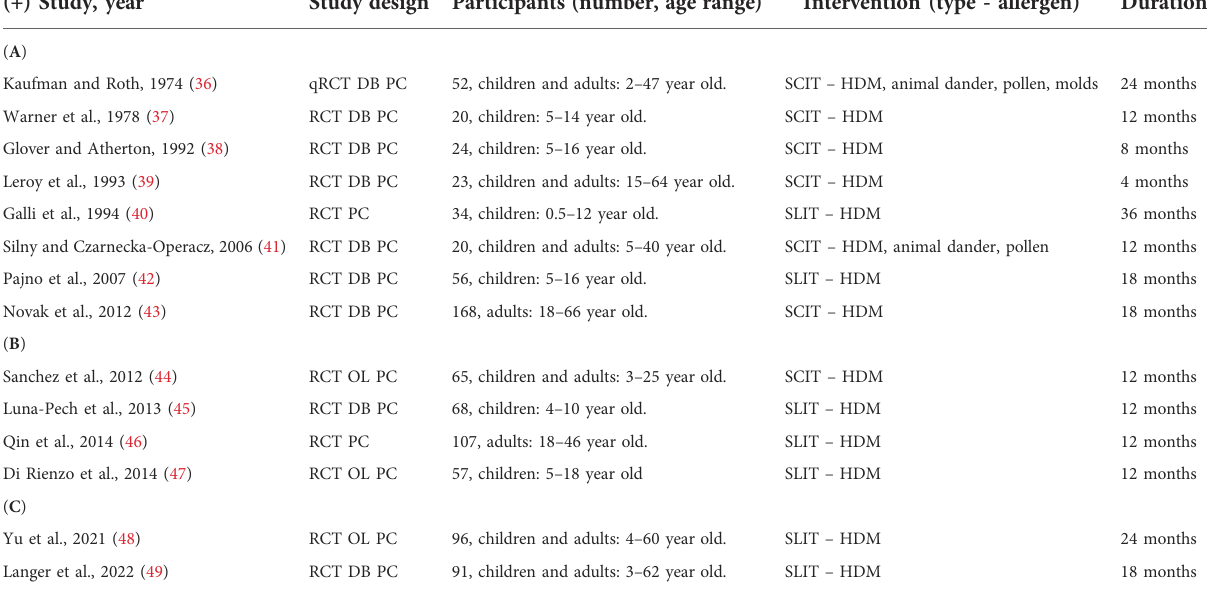
TABLE 1 Summary of the studies included in systematic review and meta-analysis, ( A ) adapted from Bae et al. (34) and ( B ) adapted from Tam et al. (35), and ( C ) of the two latest RCTs, including a pediatric population. DB, double-blind; HDM, house dust mites; OL, open label; PC, placebo- controlled; SCIT, subcutaneous immunotherapy; RCT, randomized controlled trial; SLIT, sublingual immunotherapy; y.o, years